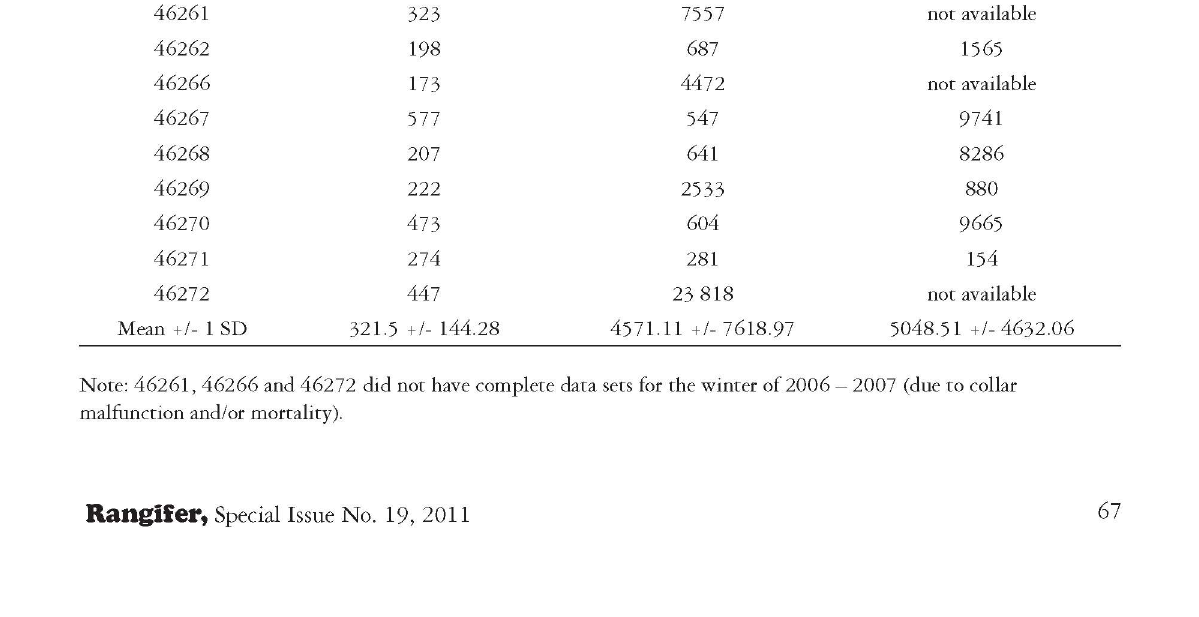
Table 4. Size of core over-wintering areas for 8 caribou in 2005, 2006 & 2007. Caribou